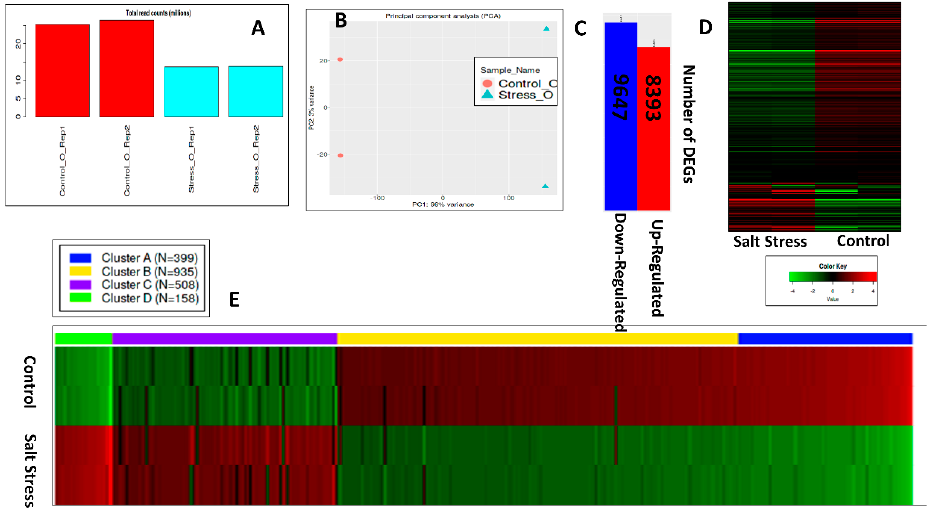
Figure 4. Identification of DEGs in cultivar Oscar under control and salt stress. ( A ) Read counts per million in four samples; ( B ) principal component analysis of RCPM; ( C ) Number of up- and down- regulated genes; ( D ) heat map displaying the clustering analysis of DEGs in up- and down-regulation; ( E ) heat map displaying the expression of DEGs based on k-means enrichment